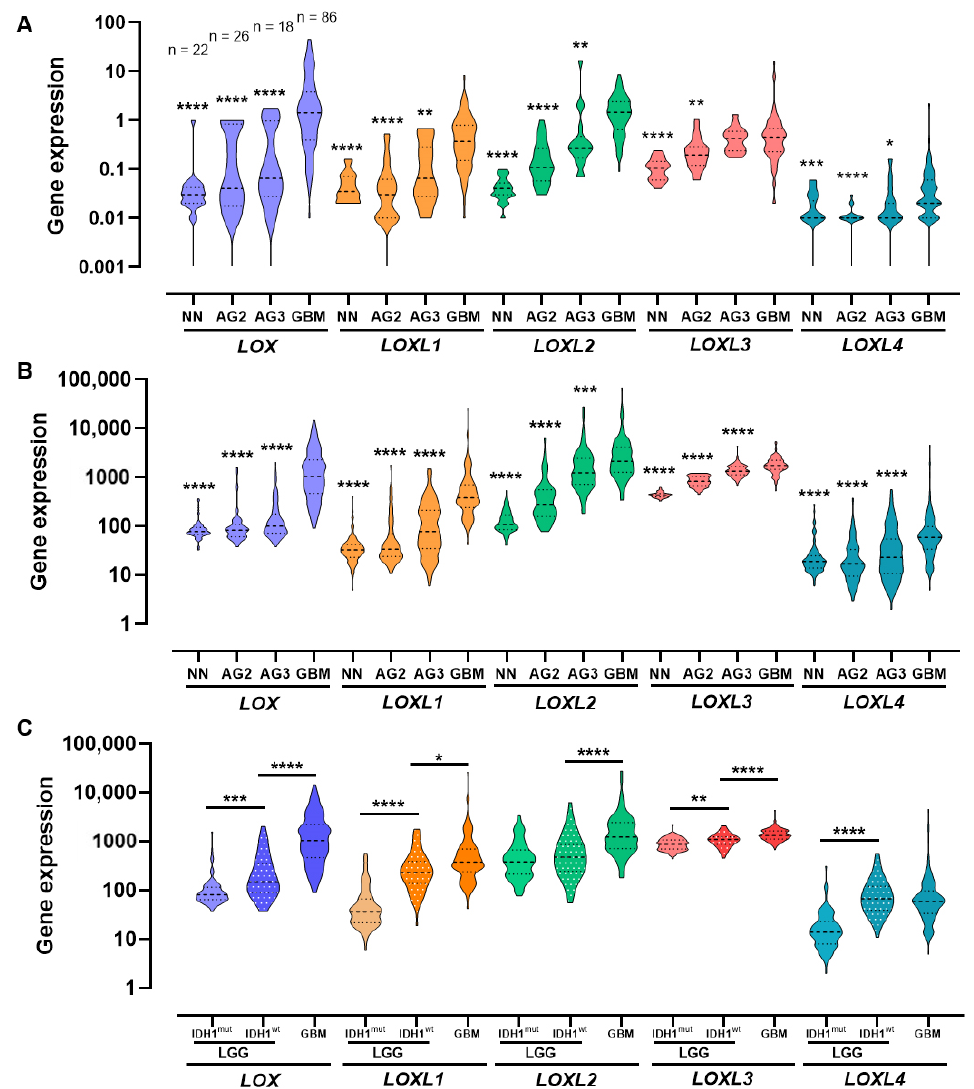
Figure 1. Violin plots showing expression distribution of genes coding for lysyl oxidase family in astrocytomas of different malignancy grades and non-neoplastic brain tissue. ( A ) Expression levels of LOX and LOXL1 – 4 in cohort determined by RT-qPCR. Statistical analysis was relative to GBM samples. The number of cases in each group is presented in the top of figure. ( B ) Expression levels of LOX and LOXL1 – 4 in TCGA (astrocytoma groups) and GTEx (NN samples) RNAseq database. Expression increased with malignancy grade of astrocytomas for the four genes analyzed. Statistical analysis was relative to GBM cases. ( C ) Expression levels of LOX and LOXL1 – 4 in TCGA RNAseq database, for LGG (AG2 and AG3) with (IDH mut ) and without (IDH wt ) IDH mutation, and GBM cases. Differences were statistically significant ( p < 0.0001) as determined by Kruskal – Wallis test for all groups of genes in both cohorts. Middle lines represent median of groups. Top and the bottom lines represent first and third quartiles, respectively. The post- hoc Dunn’s multiple comparison test was used to calculate differences between two groups (* p < 0.05; ** p < 0.01; *** p < 0.001; **** p < 0.0001). Abbreviations: AG2, low-grade astrocytoma; AG3, anaplastic astrocytoma; GBM, glioblastoma; GTEx, Genotype-Tissue Expression; IDH mut , isocitrate dehydrogenase gene with mutation; IDH wt , isocitrate dehydrogenase gene wild type; LGG, lower-grade astrocytic gliomas; NN, non-neoplastic; RT-qPCR, real-time quantitative polymerase chain reaction; TCGA, The Cancer Genome Atlas.